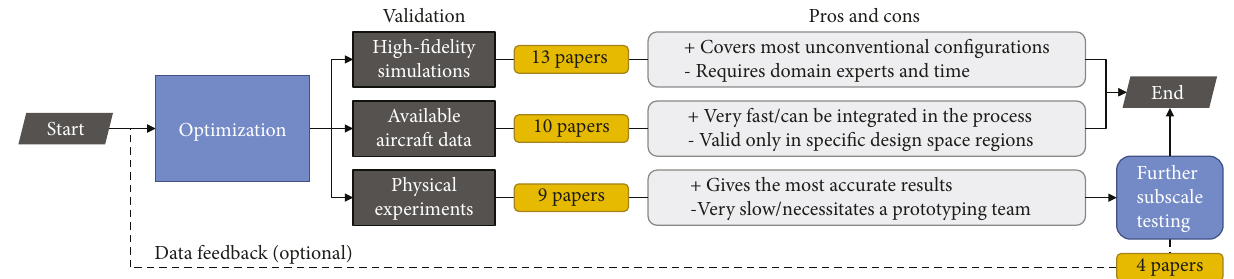
Figure 7: Overview of the three di ff erent validation